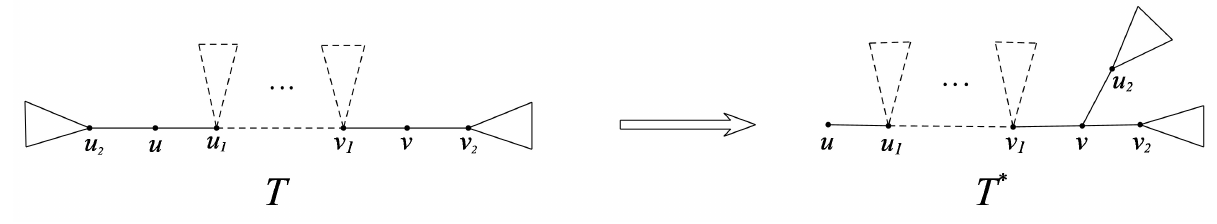
Figure 2: Transformation A used in Lemma